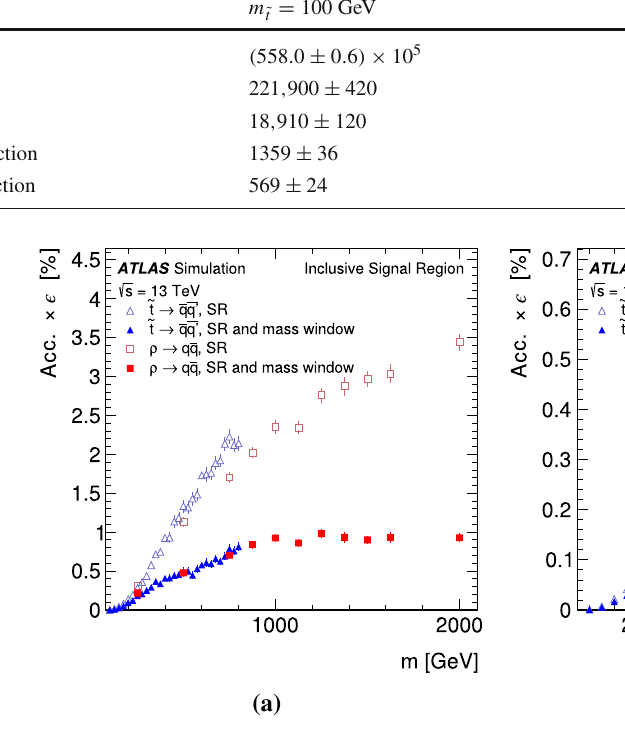
Fig. 4 The acceptance times efficiency (Acc. × (cid:11) ) of the a inclusive and b b -tagged signal region selection as a function of the resonance mass, m , before and after the mass window requirements are applied.